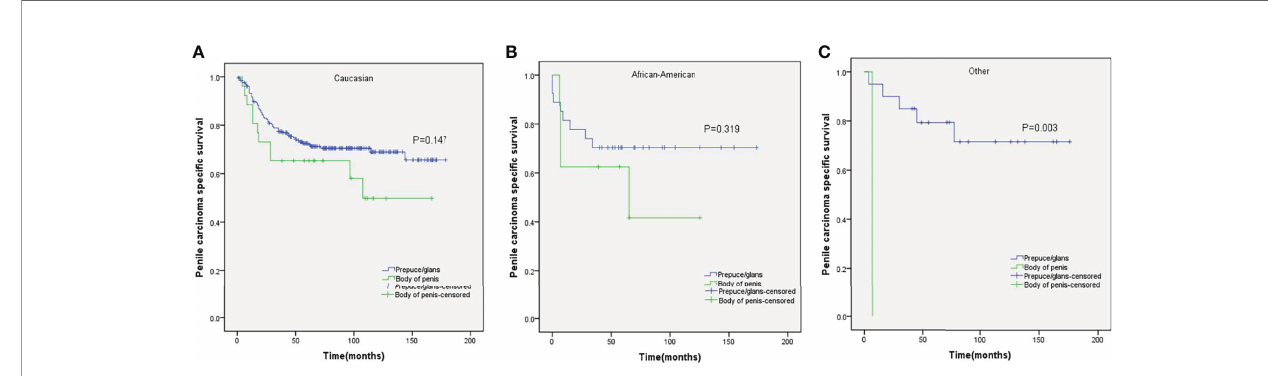
FIGURE 3 | Kaplan – Meier analyses of penile carcinoma-speci fi c survival in different ethnicities (A – C) in patients strati fi ed by tumor location.